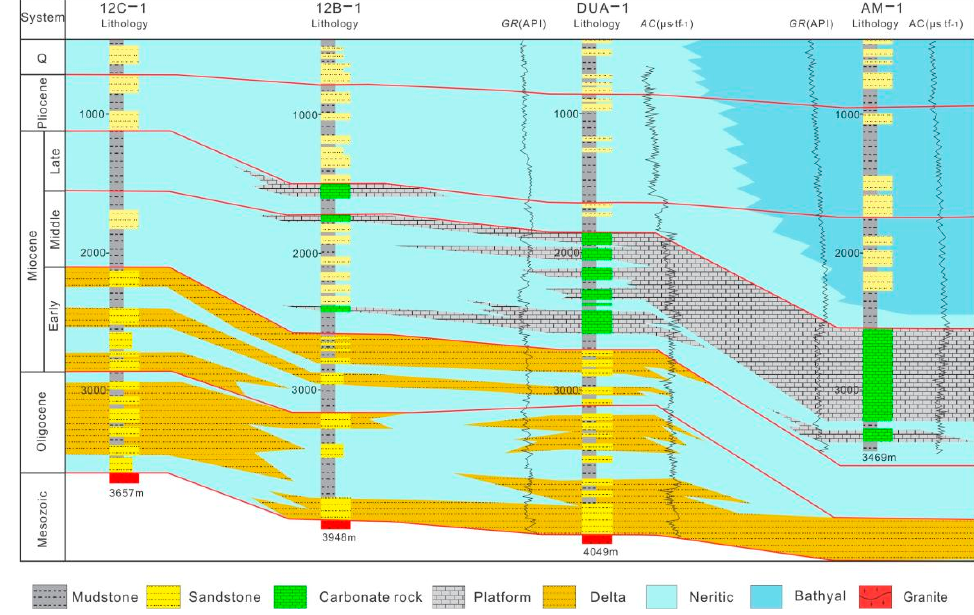
Figure 5. The associated stratigraphic columns of four wells in Wan’an Basin Well location is shown in Figure 2.